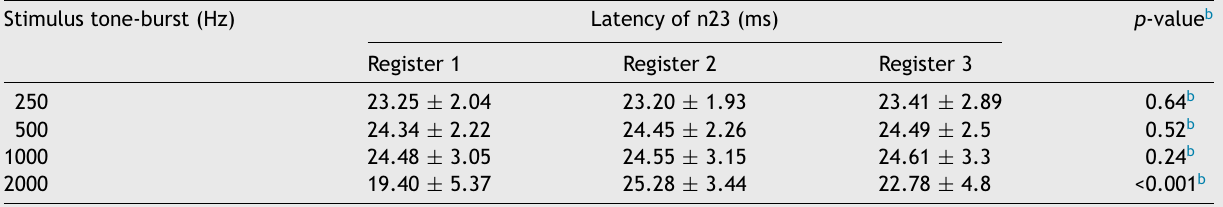
ms, milliseconds; Hz, Hertz. a Data expressed as mean ± standard deviation. b Analysis of variance test.